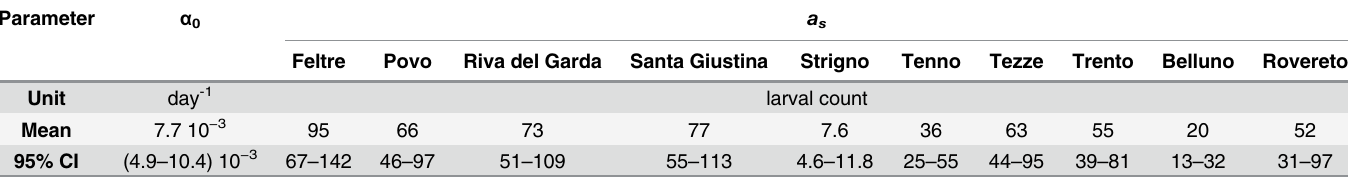
Table 2. Estimates of model parameters from the MCMC calibration